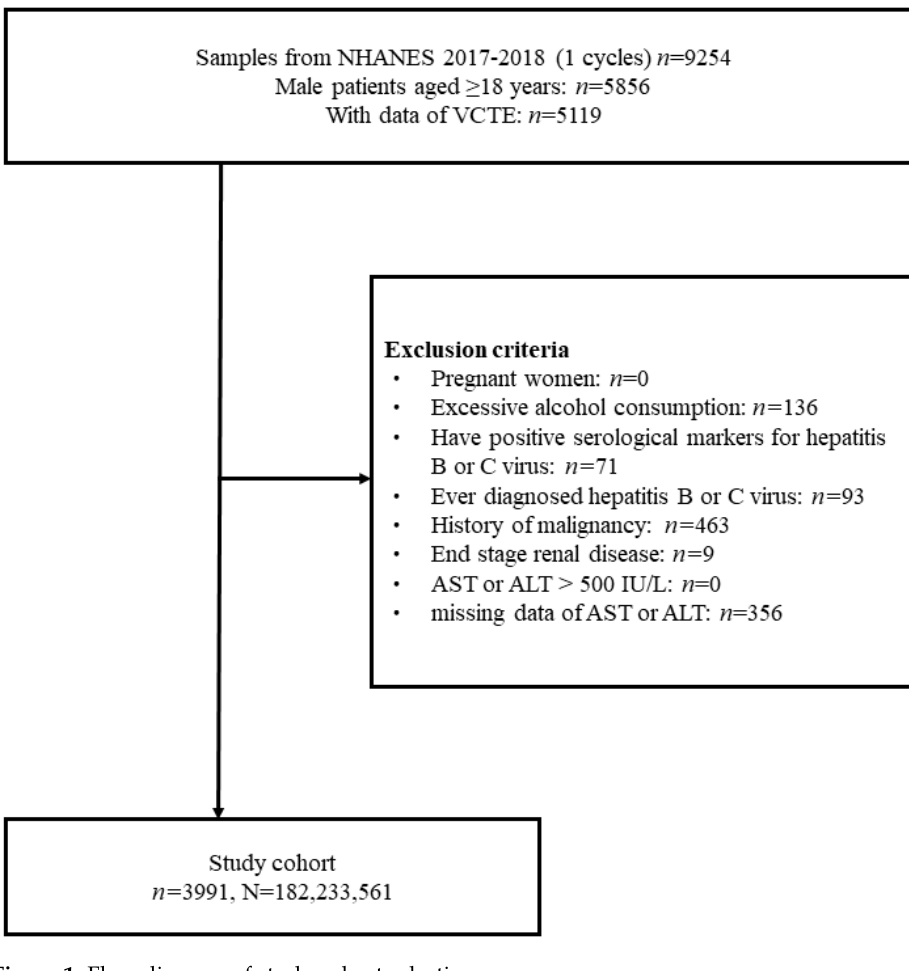
Figure 1. Flow diagram of study cohort selection.